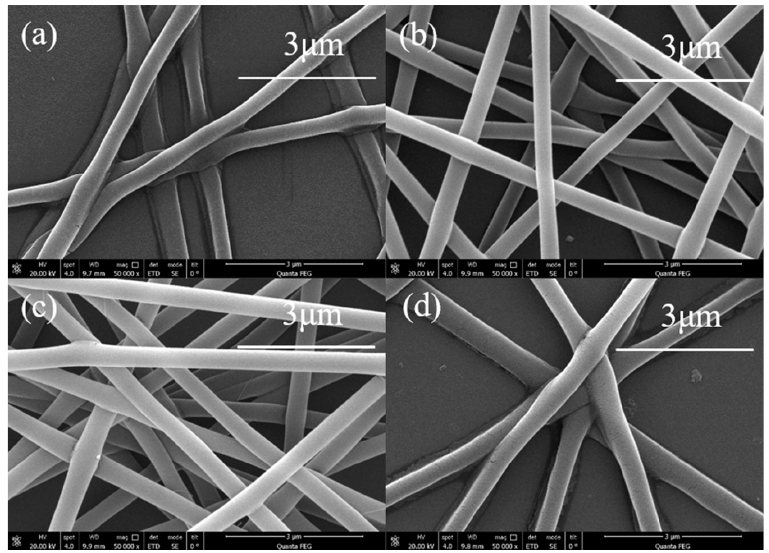
Figure 2. SEM image of PVA electrospinning nanofibers at different voltages. ( a )14.5 kV ( b ) 16.5